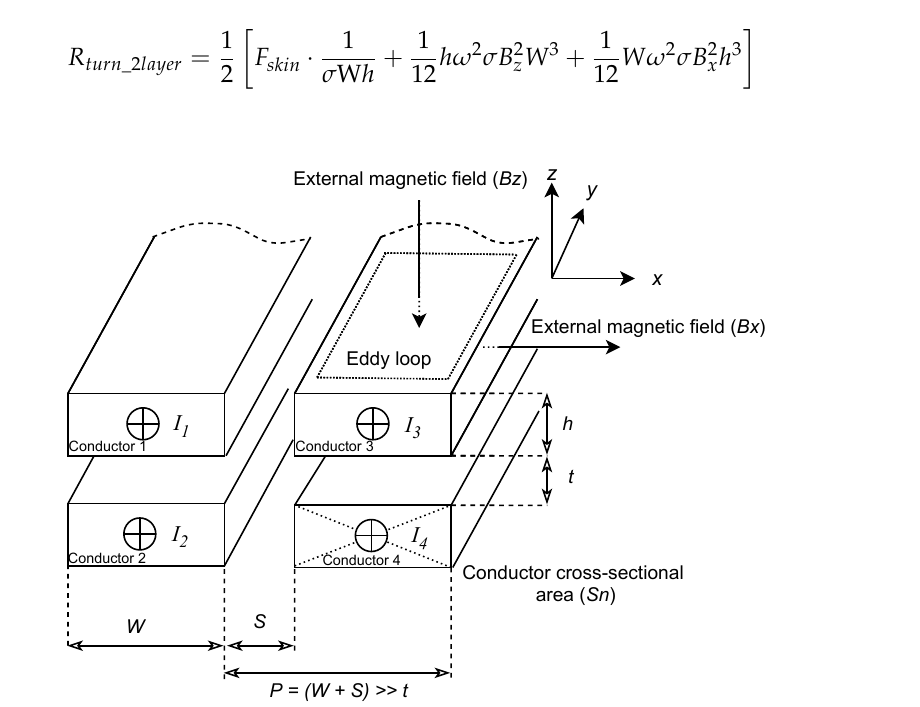
Figure 2. A copper track under external